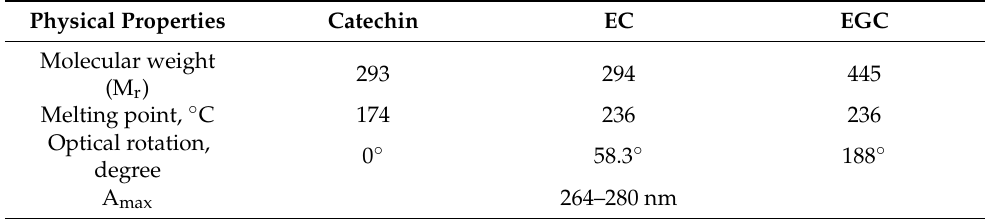
Table 3. Physical properties of the main monomeric components of